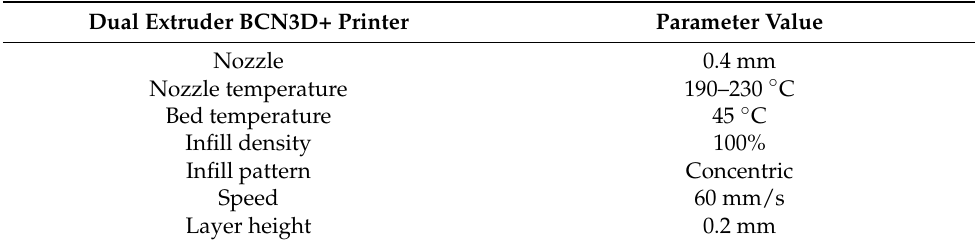
Table 2. Main 3D printer parameters